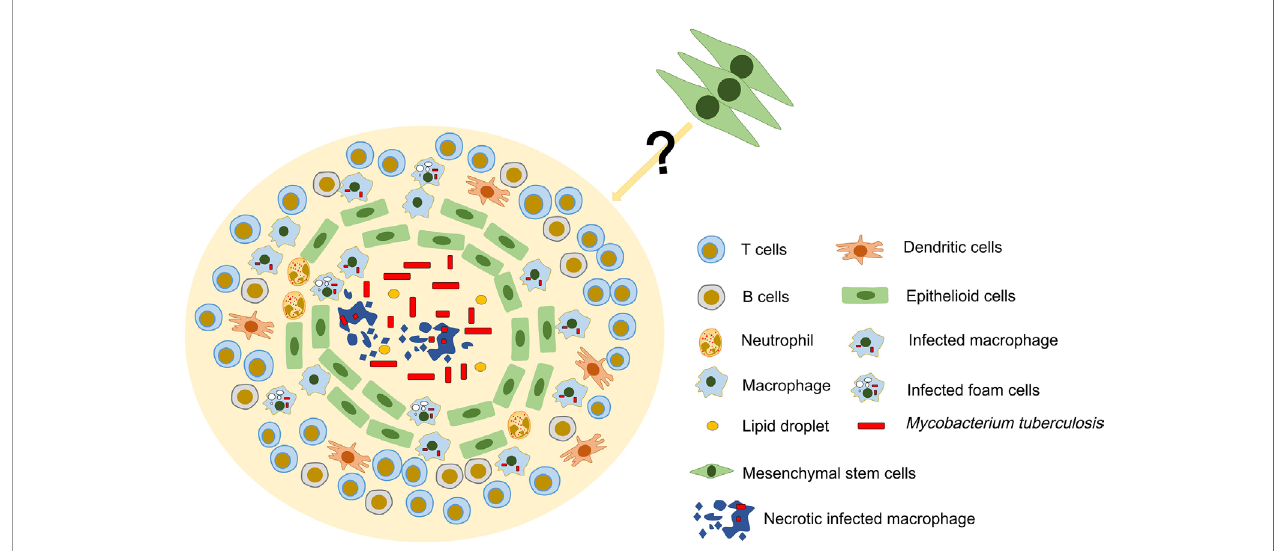
FIGURE 1 | Possible structure and cellular constituents of TG. TG is an organized aggregate of immune cells. In classic TG, there is a necrotic area in the center, surrounded by a large number of immune cells such as T cells, B cells and macrophages. MSCs have been found to exist in TG and may be involved in the formation and development of granuloma. However, the location of MSCs in TG and their relationship with immune cells are still